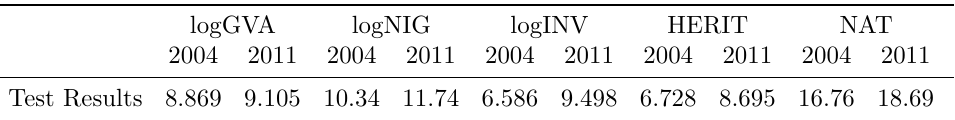
Table 2: Moran I tests for spatial autocorrelation logGVA logNIG logINV HERIT